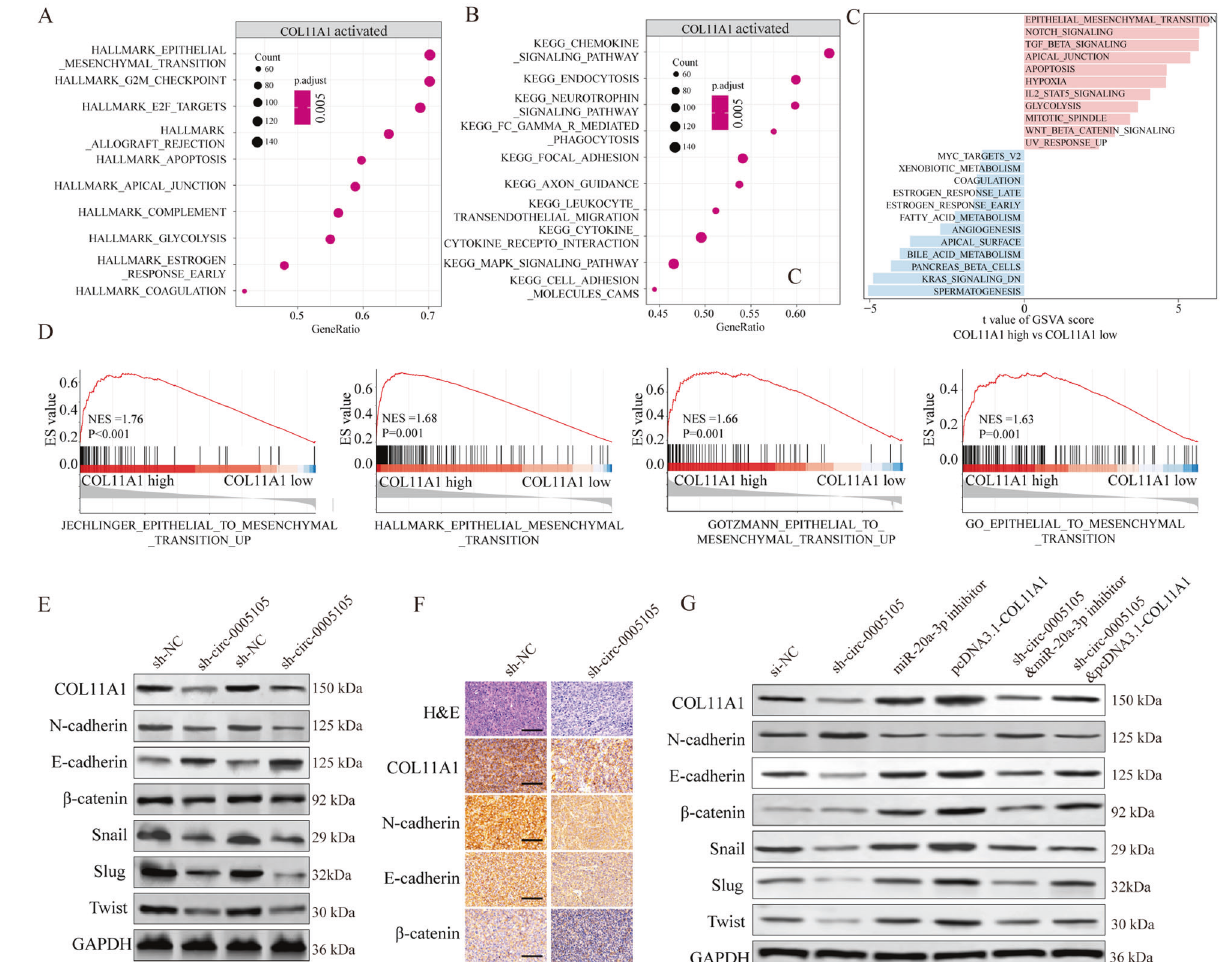
Fig. 7 circ-0005105/miR-20a-3p/COL11A1 axis activates EMT. A, B KEGG pathway enrichment analysis of COL11A1 related pathways in TCGA PAAD dataset. C Gene set variation analysis (GSVA) and ( D )The Gene Set Enrichment Analysis (GSEA) of the relationship between the expression level of COL11A1 and EMT-related gene signatures in the TCGA PAAD dataset. E, F Expression change of EMT-related proteins (N-cadherin, E-cadherin, β -catenin, Snail, Slug, and Twist) in pancreatic cells and xenograft mouse models bearing tumors under condition of COL11A1 silencing. G Expression change of EMT-related proteins (N-cadherin, E-cadherin, β -catenin, Snail, Slug, and Twist) in pancreatic cells after indicated transfection. The results are presented as the mean ± SD for each group. * P < 0.05, ** P < 0.01, *** P <